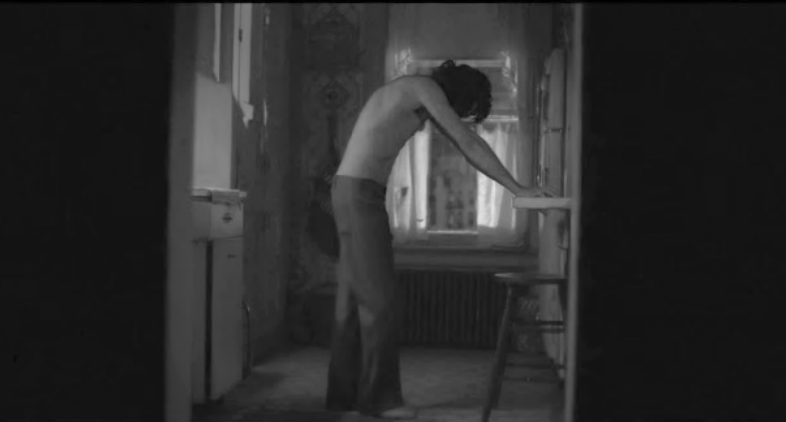
Figure 15 Colour removed. Depth of contrast minimised, as well as impact of complimentary blue and